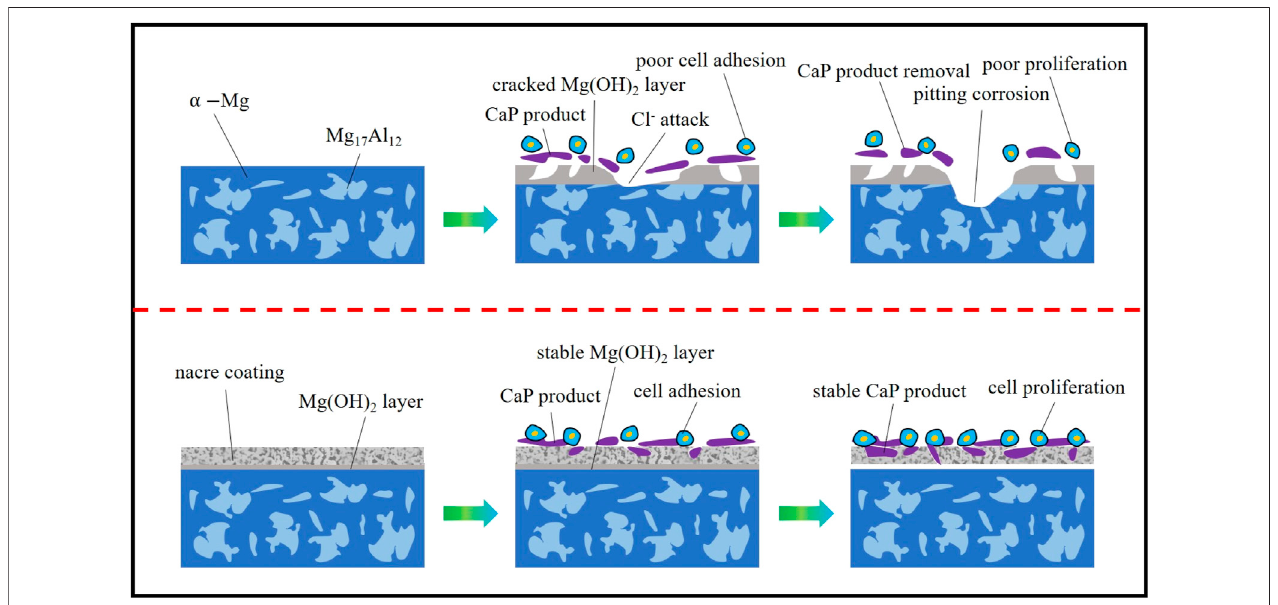
FIGURE 14 | Schematic representation of degradation control on coated sample compared to bare